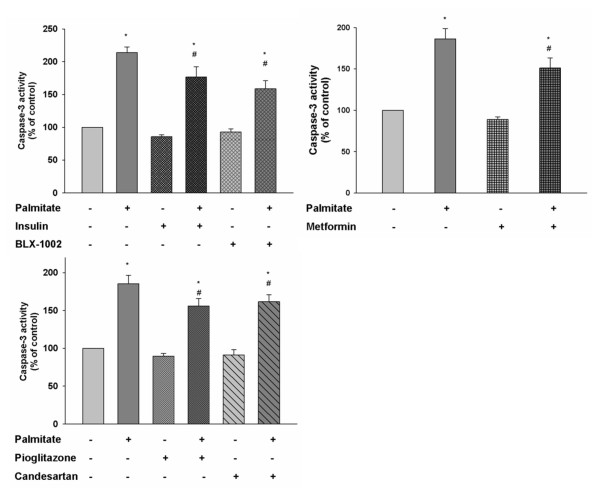
Insulin, metformin, BLX-1002, pioglitazone and candesartan protect HCAECs against palmitate-induced caspase-3 activation. Palmitate-induced caspase-3 activity, a measure of apoptosis, was evaluated using the EnzChek® Caspase-3 Assay Kit. HCAECs were incubated in medium containing 5 mM glucose, supplemented with 0.5% FBS, with or without insulin lispro (1 nM), BLX-1002 (1 μM), metformin (500 μM), pioglitazone (2.5 μM), candesartan (100 nM) in the presence of 0.125 mM palmitate or vehicle (ethanol and BSA) for 24 h. * denotes P < 0.05 for a chance difference vs. controls by ANOVA. # denotes P < 0.05 for a chance difference vs. palmitate by ANOVA.